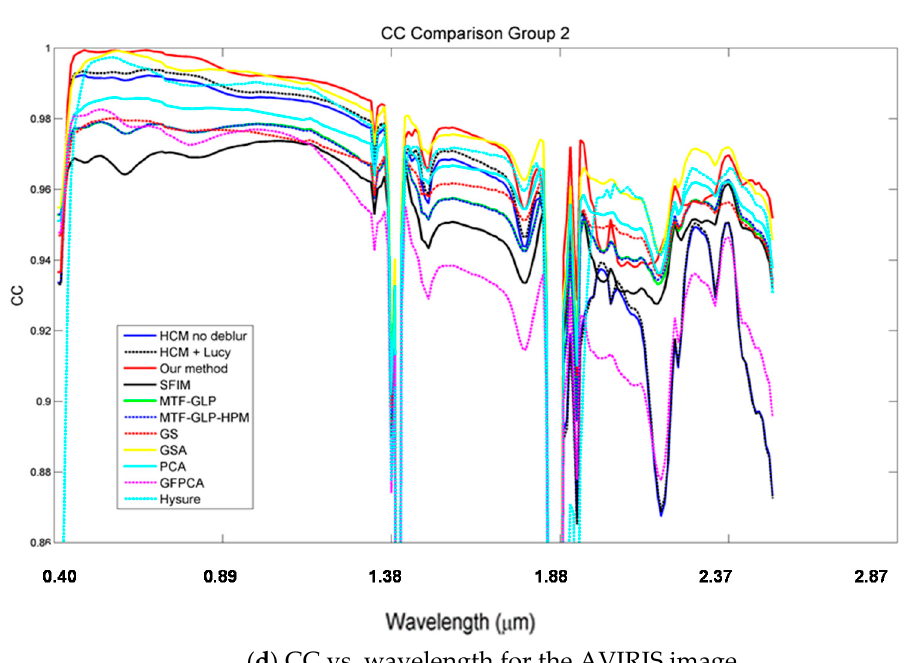
Figure 5. Comparison of RMSE and CC between our method and methods from Group 2.